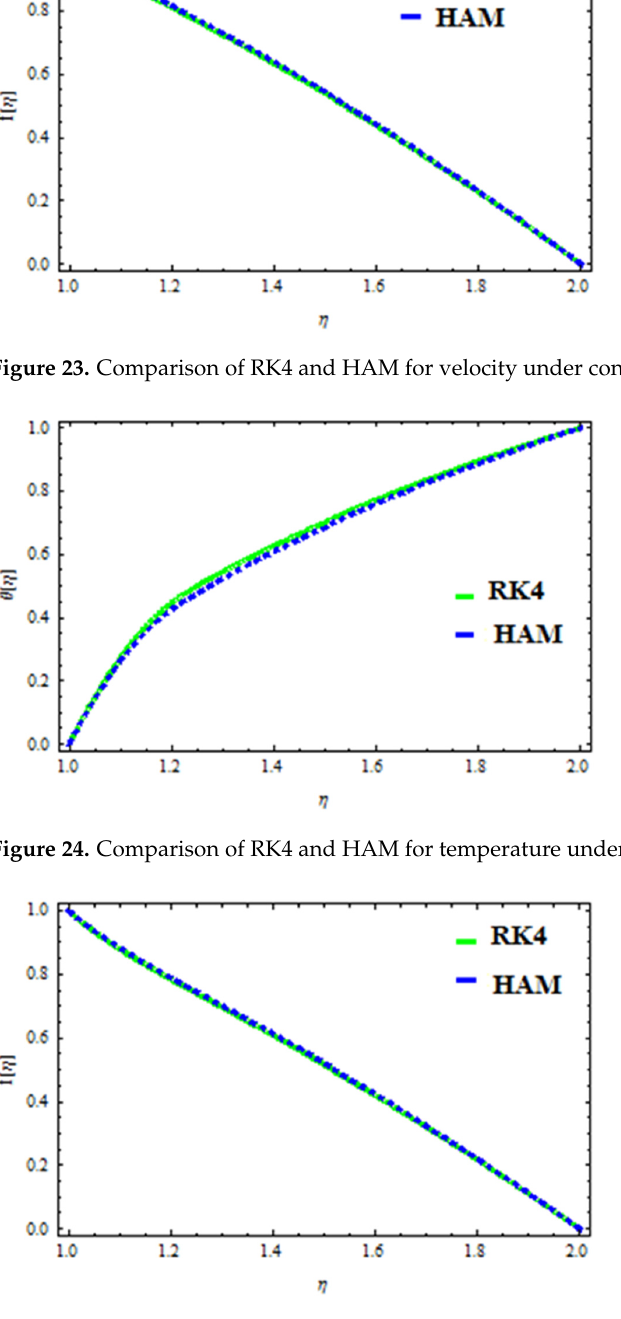
Figure 25. Comparison of RK4 and HAM for velocity in Reynolds’ model.